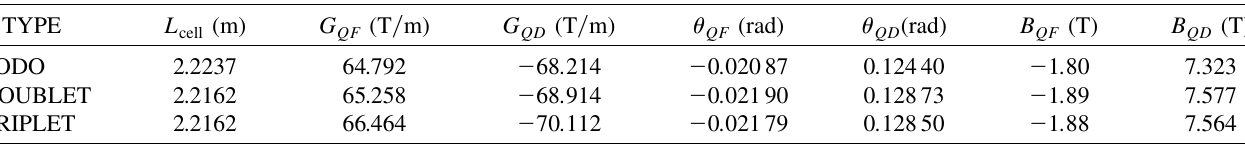
TABLE I. A comparison between designs by the FODO, DOUBLET, or TRIPLET cells. The cells properties include the length of the cells, gradient and magnet strengths, and bending angles TYPE